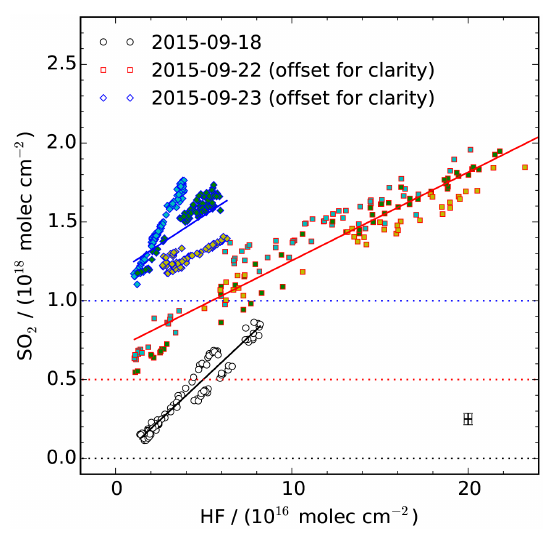
Figure 10. Correlation of (cid:49) CO 2 and SO 2 intra-plume VCDs ob- served on 18 September (black circles), 22 September (red squares), and 23 September (blue diamonds) 2015. On 22 and 23 September, we identify three separate groups. On 22 September, these groups are data recorded before 08:00hUTC (cyan filling), between 08:00 and 08:30hUTC (green filling), and after 08:30hUTC (yellow fill- ing). On 23 September, these groups are data recorded during sun- rise (cyan filling), after sunrise before 07:45hUTC (green filling), and after 07:45hUTC (yellow filling). The solid lines are fits to the daily records, fits for the intra-day subsets are omitted for clar- ity. The error bars in the upper right corner illustrate the precision estimated from the standard deviation of background soundings. For clarity, data on 22 and 23 September are offset in ordinate by 20 × 10 18 and 40 × 10 18 moleccm − 2 , respectively, as indicated by the colored dotted lines.